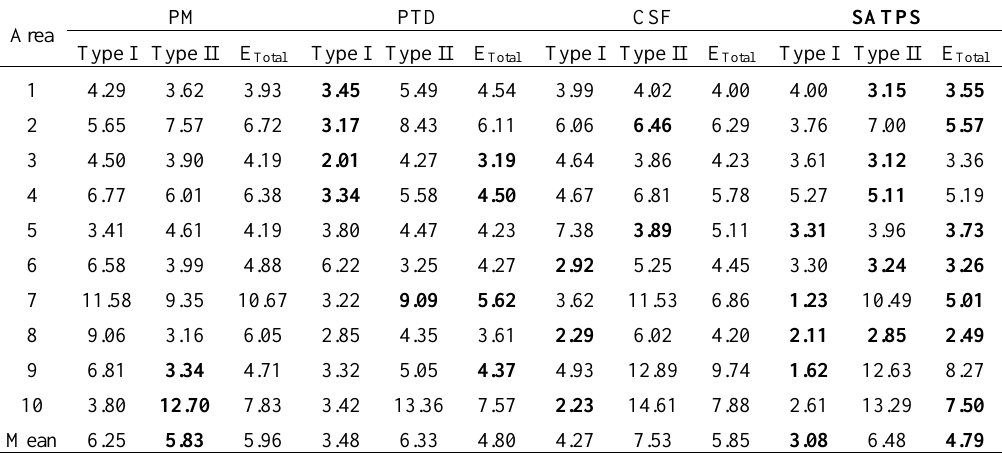
Table 2. Quantitative results of comparative methods.